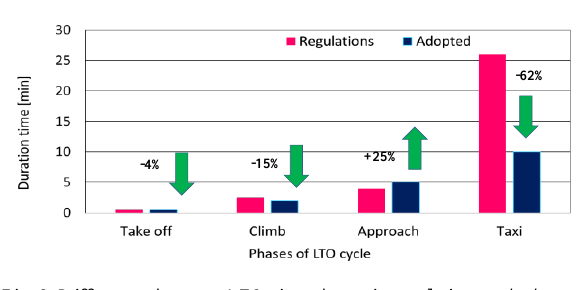
Fig. 6. Differences between LTO time phases in regulations and adopted [based on 5] Table 3. Emission factors for chosen type of aircrafts [6]